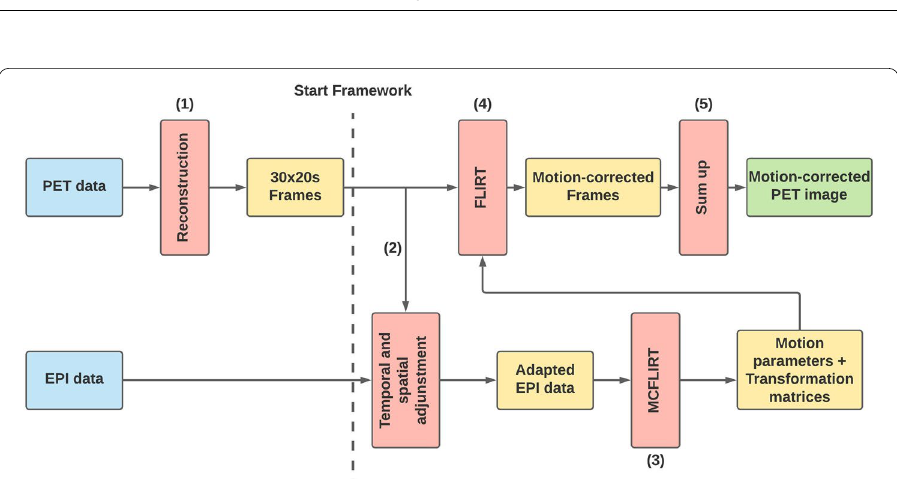
Fig. 4 Framework for reconstruction of equidistant frames using MCFLIRT. (1) The PET data was split into frames and reconstructed by the manufacturer software (Siemens). (2) The MR data (EPI) were spatially and temporally adapted to the PET data. EPI data were interpolated by miconv (ODIN [35]) which uses an Akima spline [40] for this purpose. (3) MCFLIRT was executed based on the adapted EPI data. (4) The resulting transformation matrices are then applied to the PET frames. (5) Finally, all motion-corrected frames are